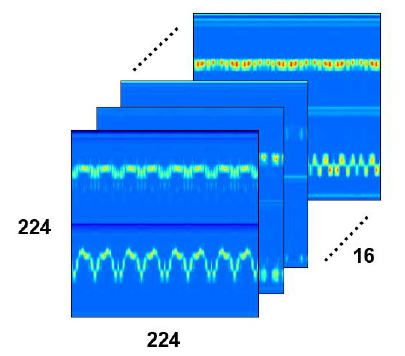
Figure 7. The illustration of stacking 16 heatmaps to one 3D feature map. The size of a single heatmap is 224 × 224. 16 heatmaps are combined together to form a feature map with the size of 224 × 224 × 16. We apply four metrics for exercise counting and one metric for action recognition. The four counting metrics include Mean Absolute Error (MAE), Off-By-One (OBO), Average Error (AE) and Standard Deviation ( σ ). Accuracy is leveraged as our exercise recogni- tion